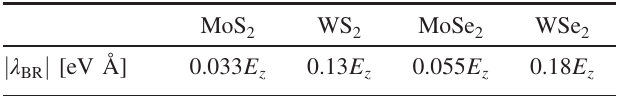
TABLE III. Estimates of the Bychkov-Rashba SOC parameters j λ BR j . The perpendicular electric field E z is in units of V =